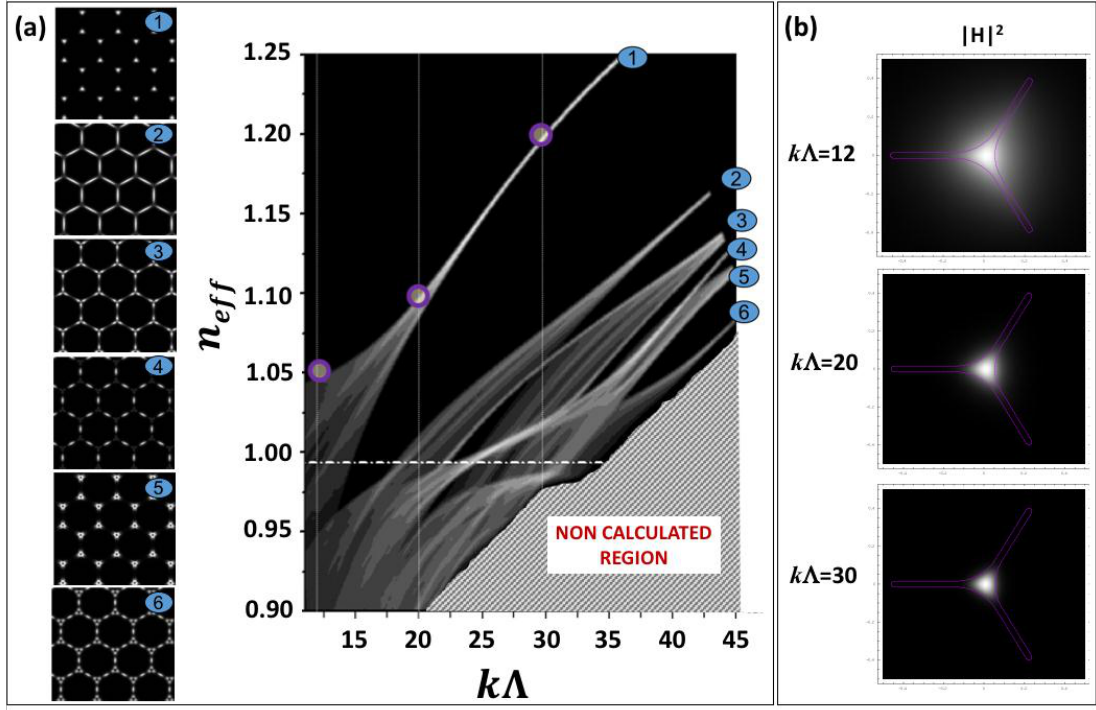
Figure 10. ( a ) Propagation diagram for the HCPCF cladding lattice with a gallery of the different guided modes. ( b ) Evolution of the interstitial apex mode for different k Λ